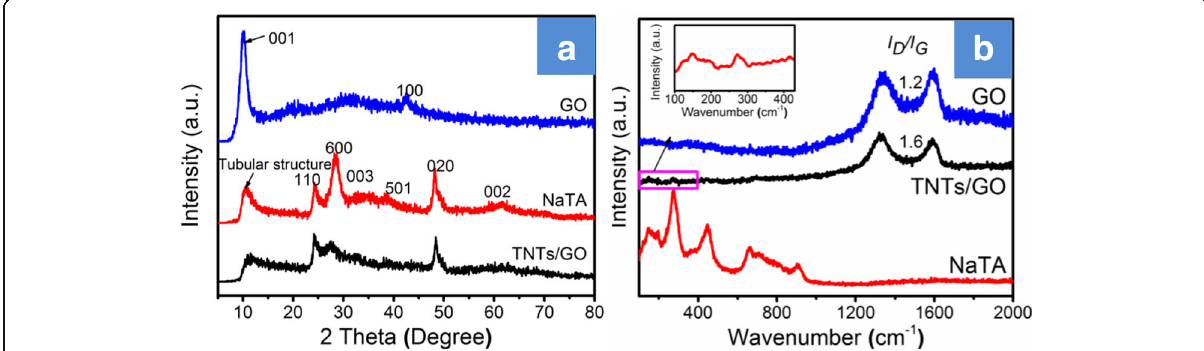
Fig. 1 XRD patterns a and Raman patterns b of GO, NaTA, and TNTs/GO nanocomposites. The XRD patterns displayed that GO was exfoliated into sheets. The Raman patterns further verified the attendance of GO and proved that TNTs are successfully incorporated into GO nanosheets to provide TNTs/GO